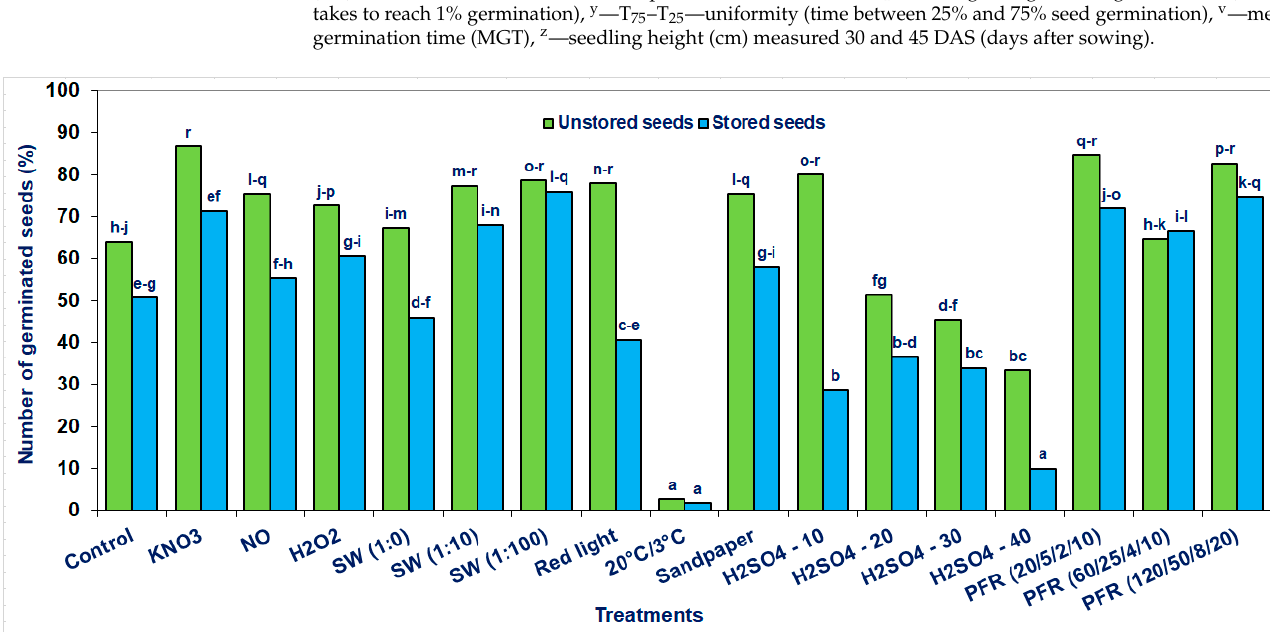
1 The data marked with the same letters within a column are not significantly different according to Tukey’s test (5%). Values are the means of four replications of 50 seeds. x T 1 —the beginning of seed